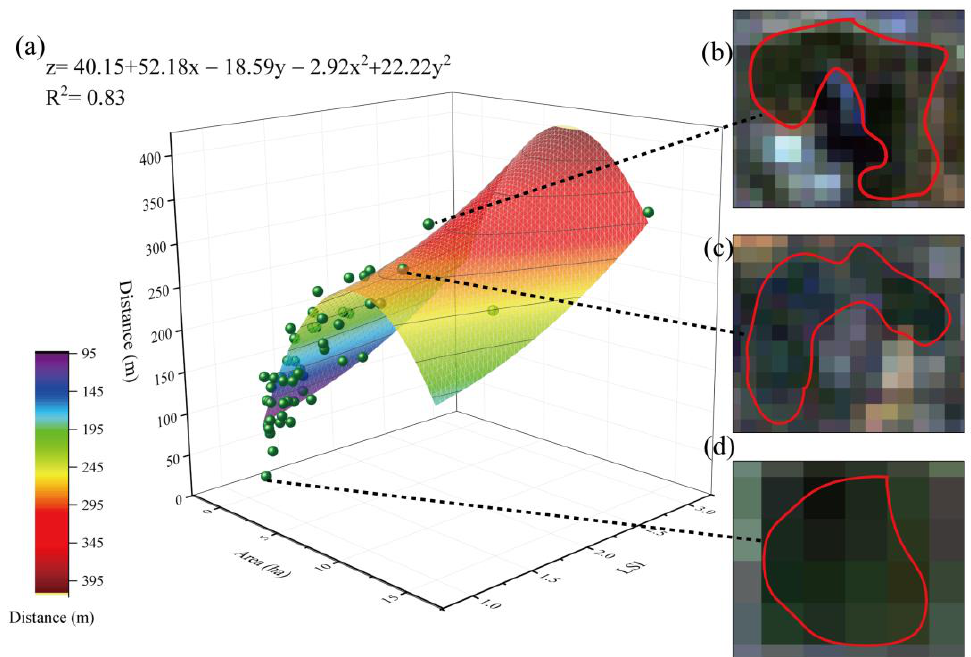
Figure 4. Relationships among green space area, LSI, and cooling distance. ( a ) Function description; ( b ) sample 1, a green space with an area of 9.33 ha and LSI of 1.57; ( c ) sample 2, a green space with an area of 5.97 ha and LSI of 1.50; and ( d ) sample 3, a green space with an area of 1.03 ha and LSI of 1.06.